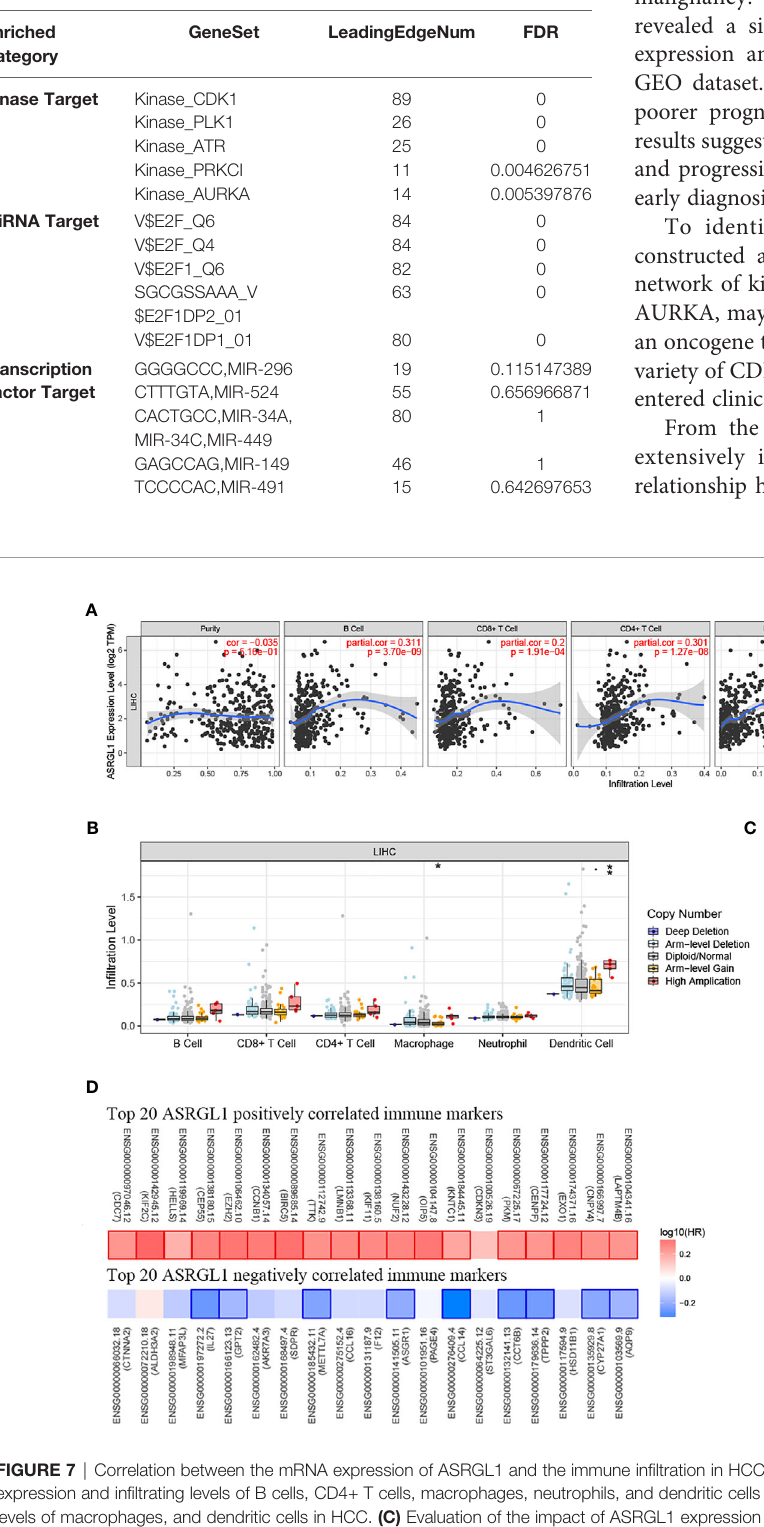
TABLE 2 | The Kinases, miRNAs and transcription factors-target networks of ASRGL1 in HCC.